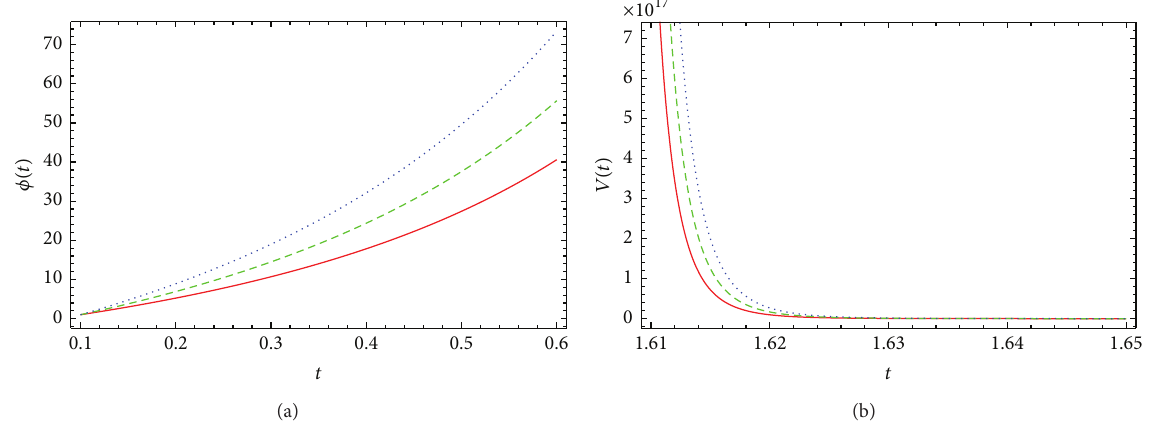
Figure 8: Plots of 𝑓(𝑅,∇𝑅) hessence scalar field model: (a) 𝜙 versus cosmic time 𝑡 and (b) potential 𝑉 versus 𝑡 for 𝑛 = 1 (red), 𝑛 = 2 (green), and 𝑛 = 3